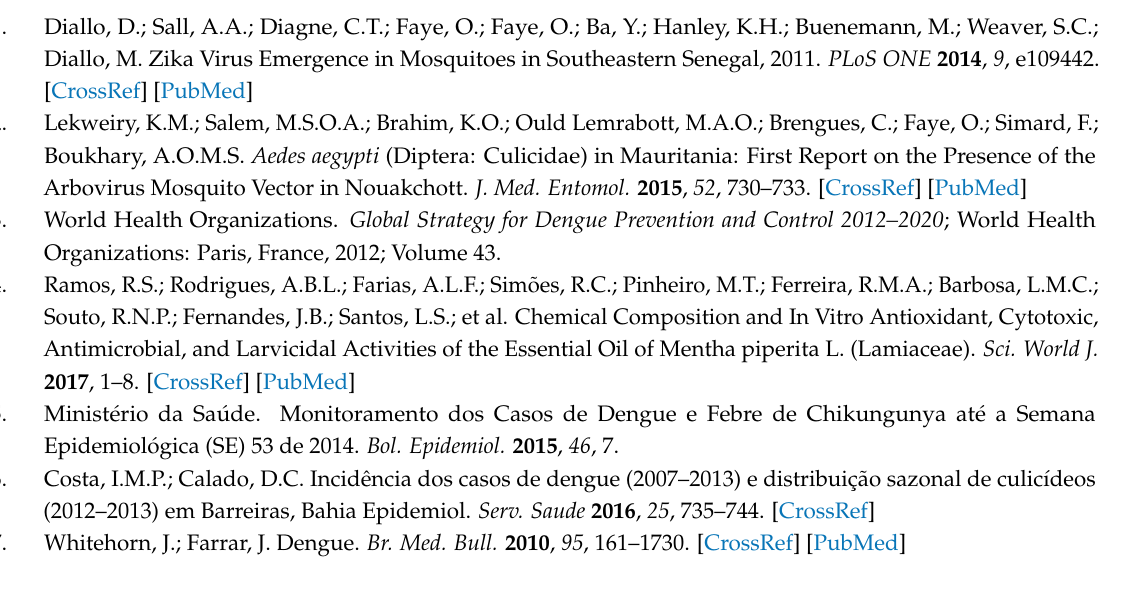
Table S1. Type of interactions observed between acetylcholinesterase and the most promising molecules, Table S2. Type of interactions observed between human acetylcholinesterase and the most promising molecules, Table S3. Binding receptor interaction data juvenile hormone of the most promising